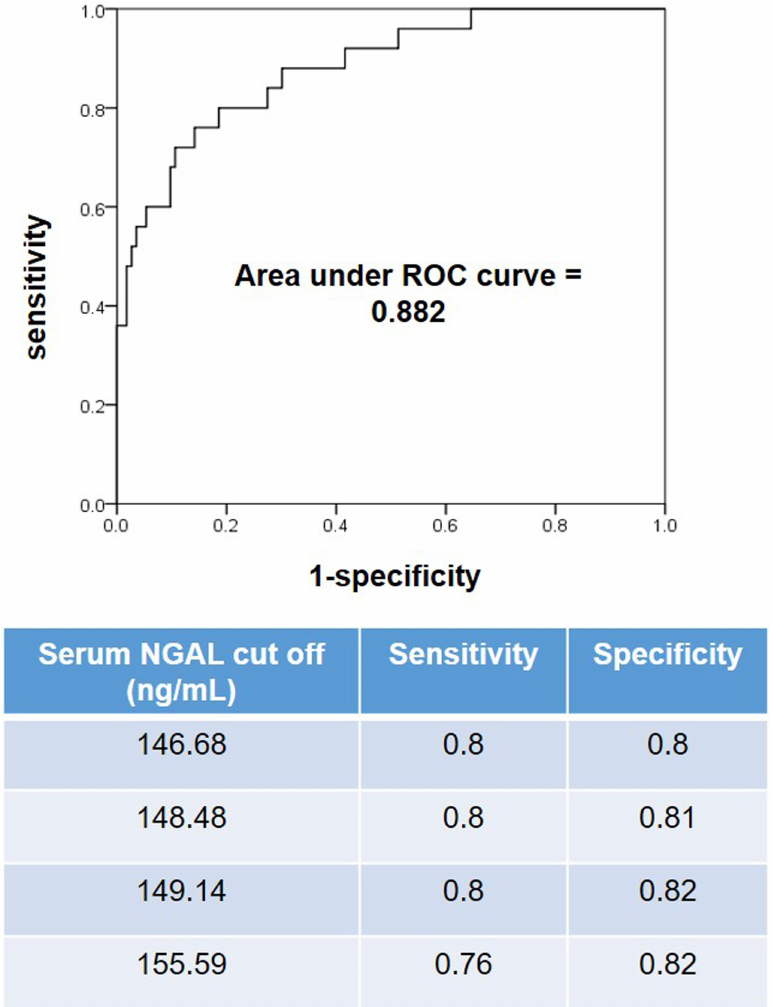
Fig 1. Receiveroperating characteristic curve and performance characteristics for serum NGAL upon admission. The area under the ROC curve for the serum NGAL test is 88% (CI 0.808–0.956).